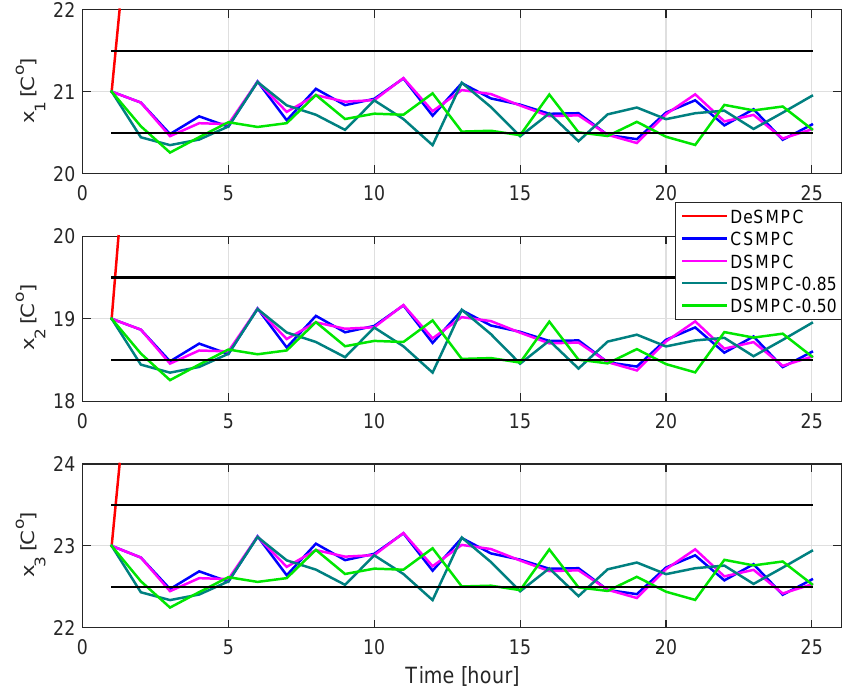
Figure 1. A-posteriori feasibility validation of the obtained results. The “red”, “blue”, “magenta”, “dark green”, and “light green” lines are related to the obtained results via DeSMPC, CSMPC, DSMPC, DSMPCS − 0.85, and DSMPCS − 0.50, respectively. The “black” lines are related to the upper bound values. The top, middle, and down plots are related to the temperatures of room 1,2, and 3,